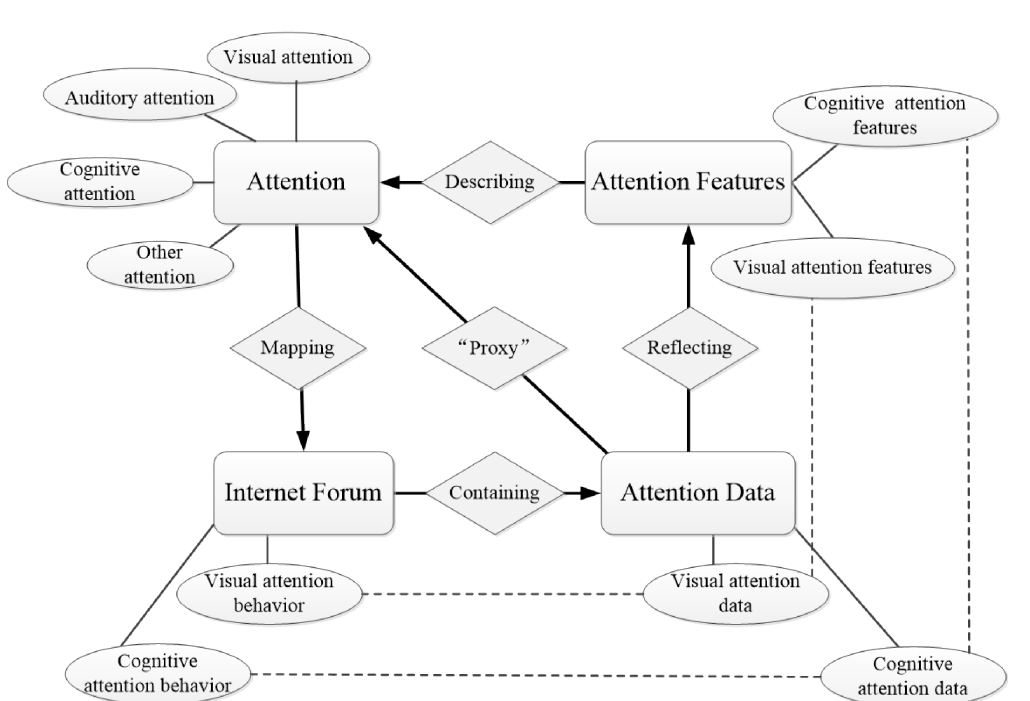
Figure 1. The conceptual model of this